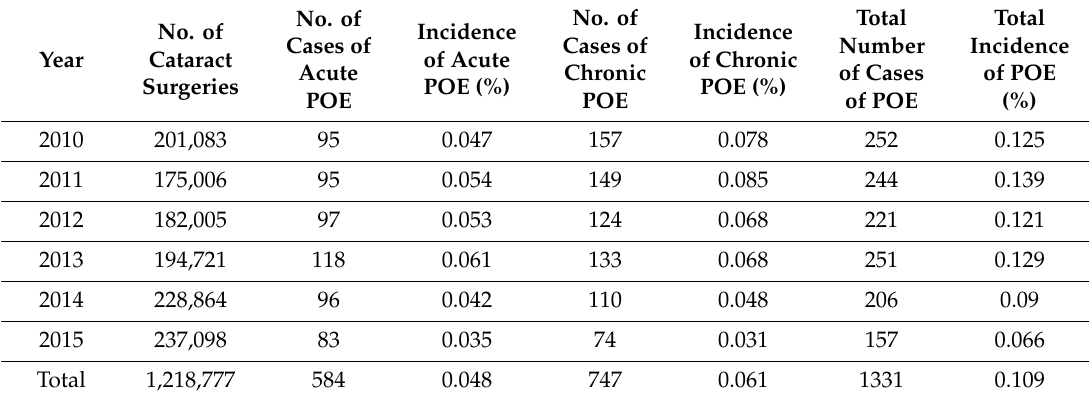
Table 2. Incidence of acute and chronic postoperative endophthalmitis (POE) after cataract surgery in Poland from 2010–2015.